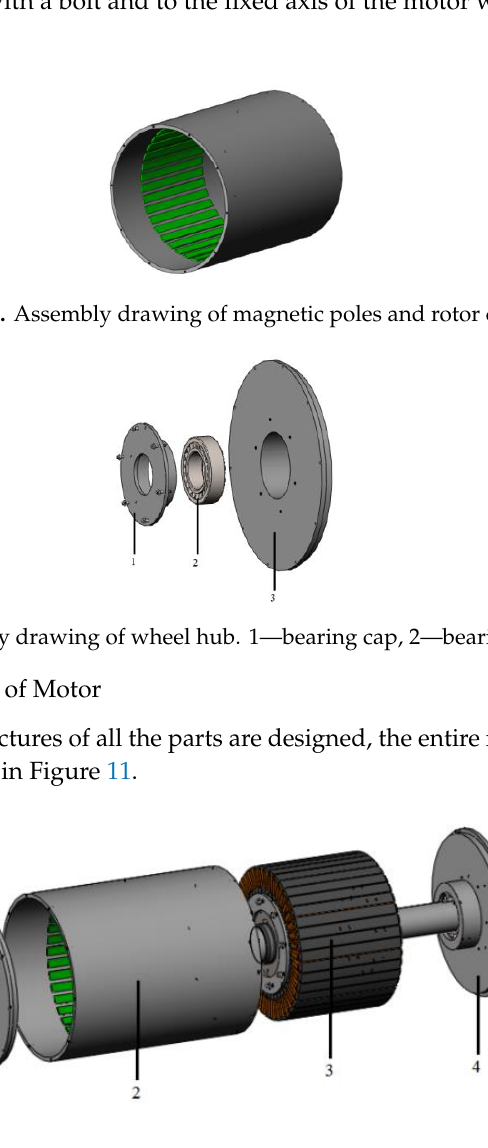
Figure 11. Assembly drawing of the whole motor structure. 1,4 — wheel hub, 2 — outer rotor, 3 — stator.